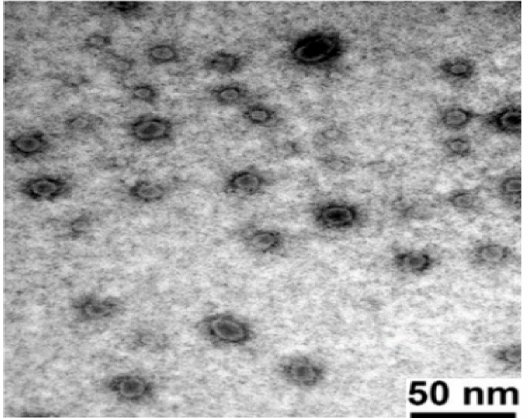
Figure 5. Transmission electron microphotography (TEM) of the reconstituted F1 formulation.